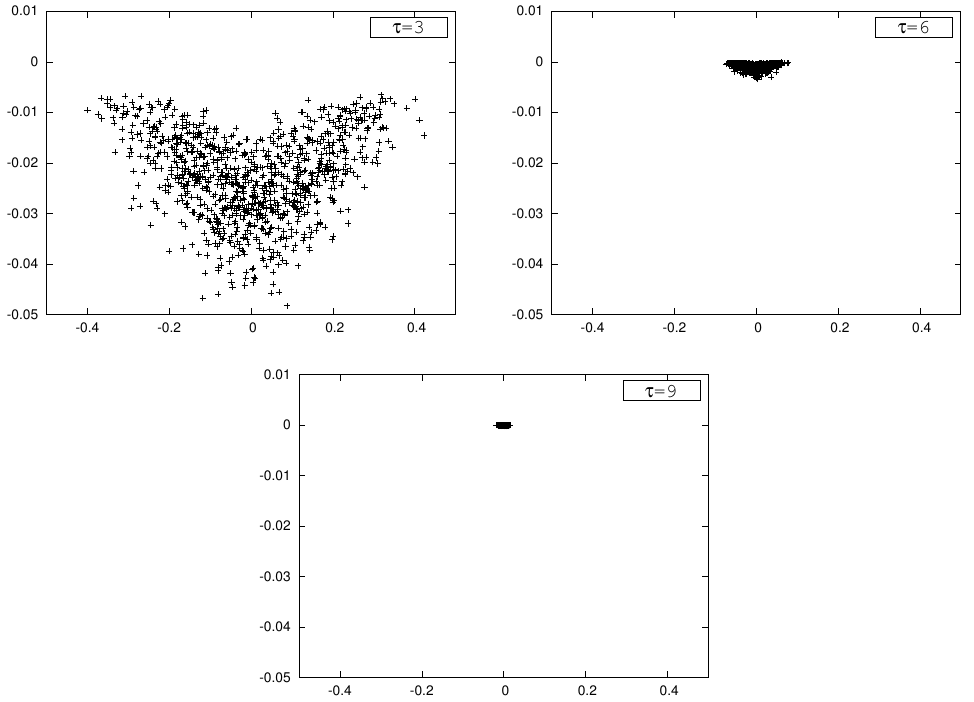
Figure 4 . Zoom up of the distribution of z in the case (i) for (cid:28) = 3 ; 6 ; 9.